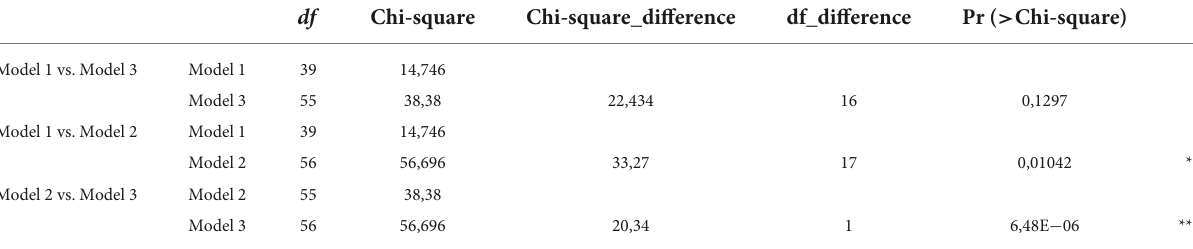
TABLE 7 Comparison of the three random-intercept cross-lagged panel models. df Chi-square Chi-square_difference df_difference Pr ( >